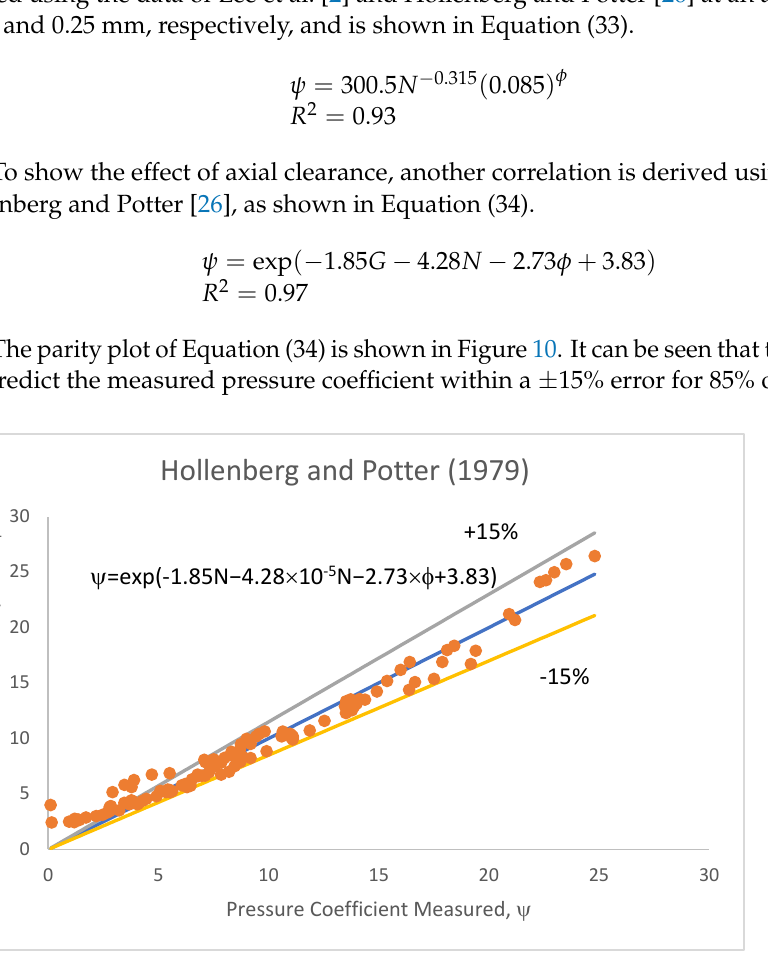
Figure 10. Parity plot of the pressure coefficient of blowers as measured and computed by correla ‐ tion.